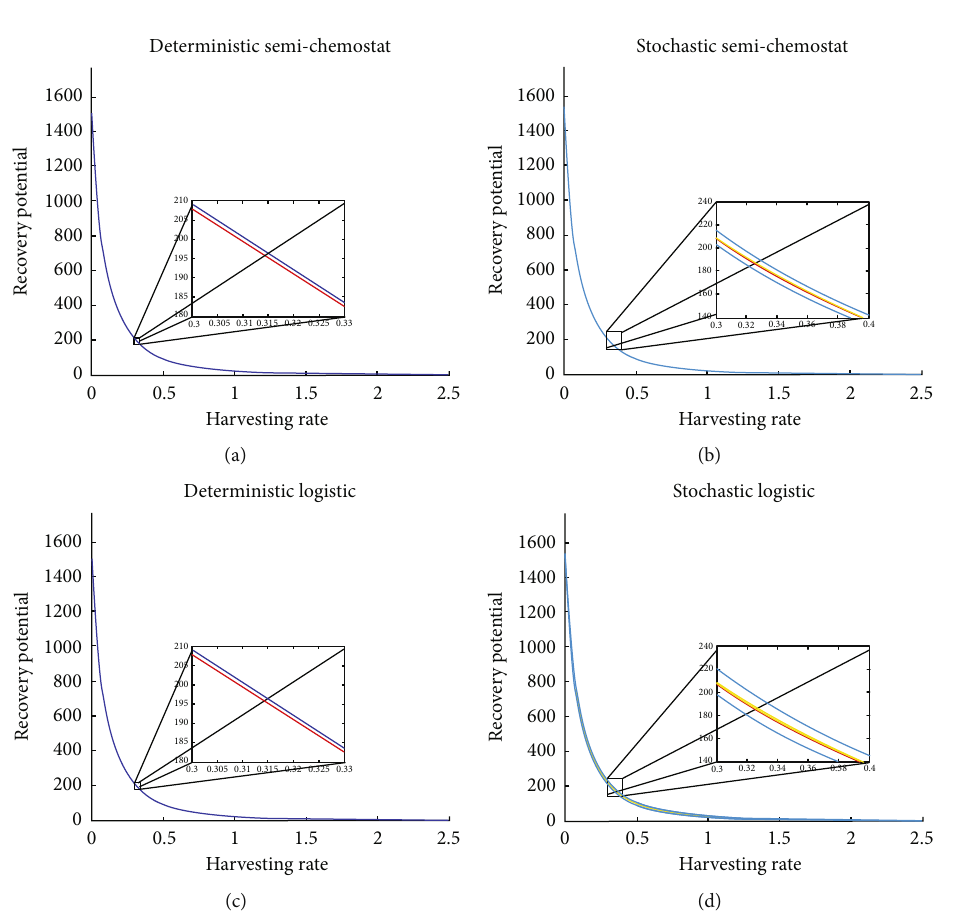
Figure 2: The recovery potential is calculated by using the algorithm described in Appendix B.2. Meng et al. recovery potential (red curve) and nonequilibrium recovery potential (blue curve) w.r.t. harvesting rate for deterministic case (a, c). The mean value of the stochastic nonequilibrium recovery potential (yellow curve) and the interval of standard deviation (68%) of the stochastic nonequilibrium recovery potential (light blue curves) w.r.t. harvesting rate (b,